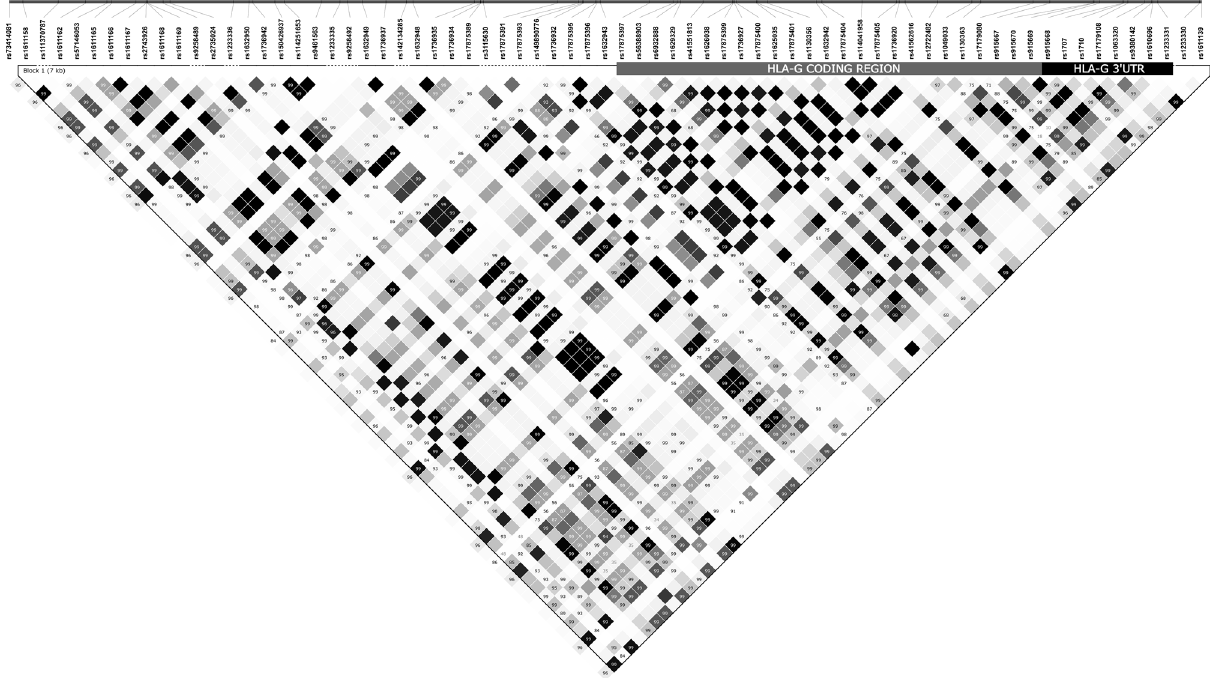
Figure 1. Linkage disequilibrium between pairs of 106 bi-allelic SNPs at the HLA-G gene region, starting from 4 Kb upstream the gene up to 100 nucleotides downstream, all presenting a global minimum allele frequency of 1%. The image was generated in the Haploview and further edited by using Inkscape. Areas in black indicate strong LD ( r 2 > 0.8), shades of gray indicate moderate LD, and white indicates low